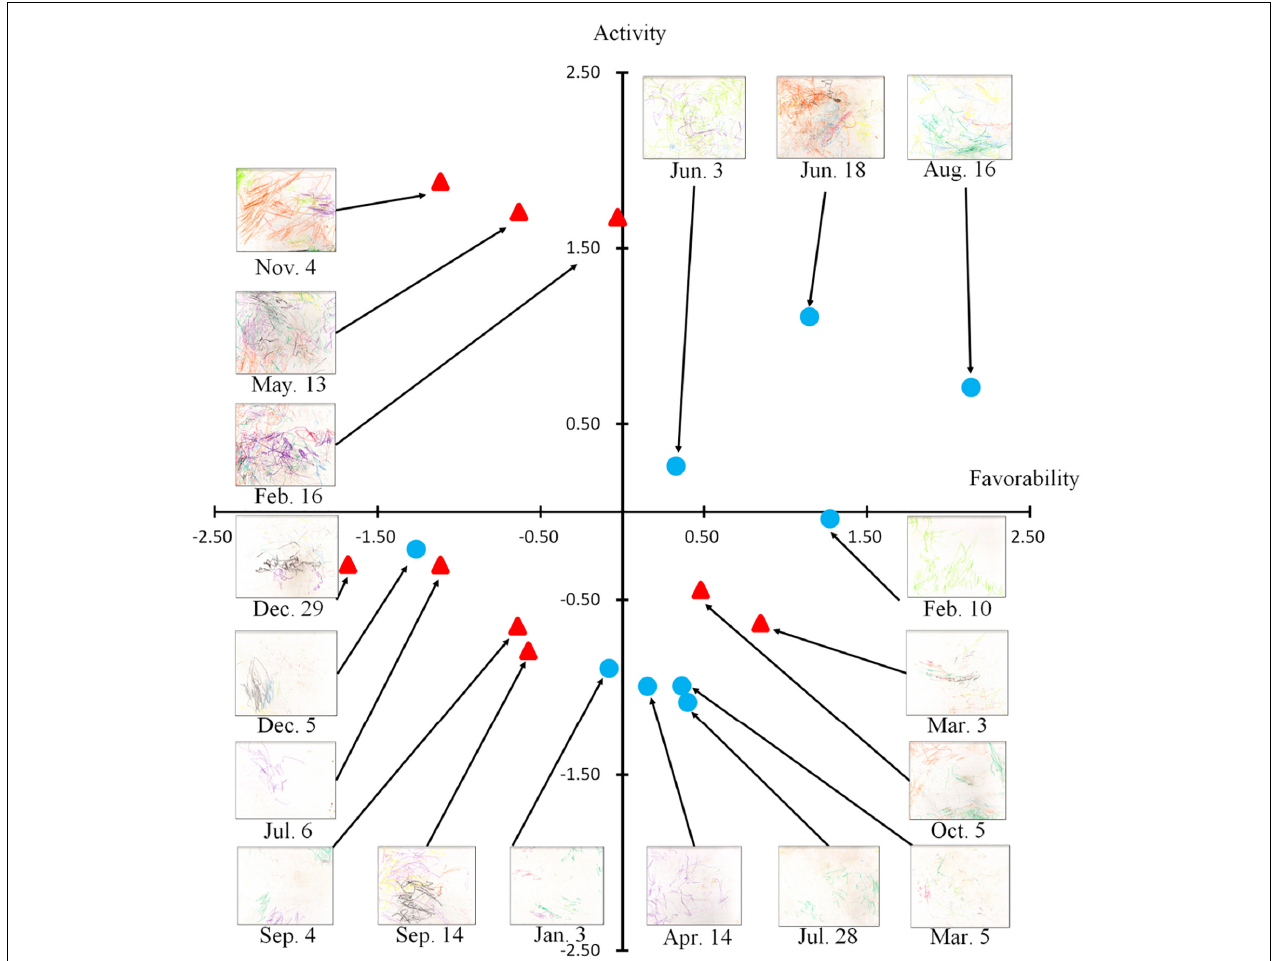
FIGURE 3 | Results of the factor analysis. The horizontal axis reflects the favorableness score, and the vertical axis reflects the activity score. The drawings by the orangutan are located relative to the two dimensions. The date under each drawing indicates the day it was produced, between April 2006 and March 2007. The blue circle indicates a day Molly produced the drawings in the presence of the older male keeper. The red triangle indicates a day Molly produced the drawings in the presence of the younger female keeper.